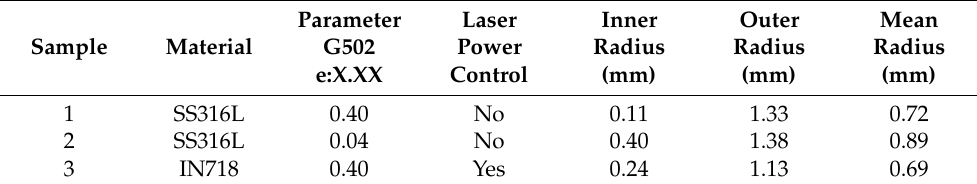
Figure 10. Radius of curvature in thin walls made with powder LMD. SS316L walls without power control with e = 0.40 ( left ), e = 0.04 ( center ) and wall in IN718 with e = 0.40 and power control ( right ). Table 4. Measured inner and outer radius